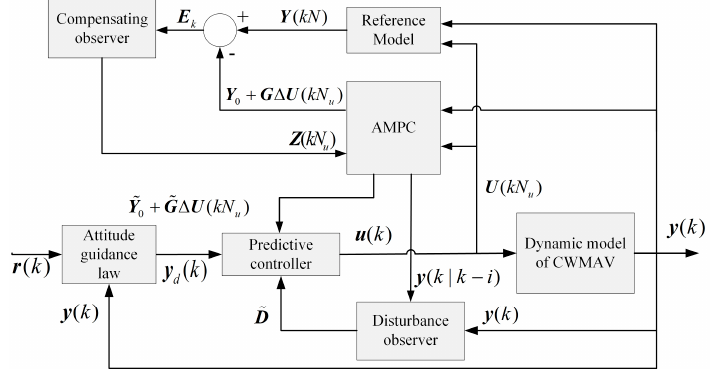
Figure 1. Schematic diagram of the proposed modeling framework.